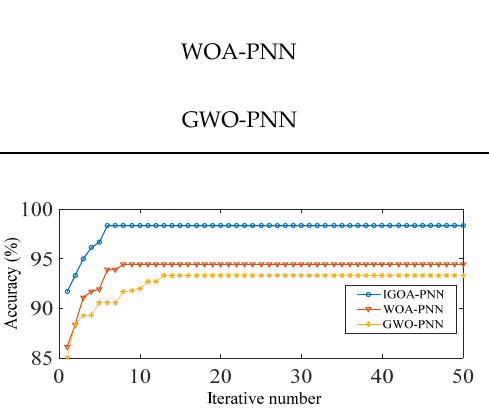
Figure 14. HVSR fault identification results for different models.